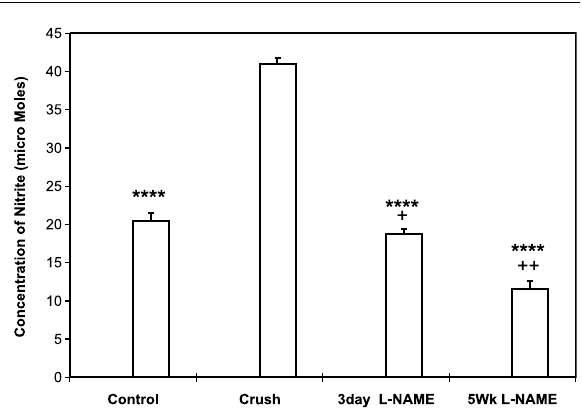
FIG. 1. Release of nitrite from explant cultures of digital flexor tendon and synovium. Explant cultures were taken from (i) control uninjured rats, (ii) crush injured rats after 3 days, and rats treated with L-NAME immediately after crush injury and sacrificed (iii) 3 days and (iv) 5 weeks post-injury. Explant cultures were incubated for 3 days at 37 8 C and the accumulation of nitrite, the stable endproduct of NO, was measured in the supernatant, as described previously. Error bars represent standard error of the means. ****p B / 0.0001 versus crush injury (no L-NAME); (cid:2) p B / 0.05 and (cid:2)(cid:2) p B / 0.005 versus